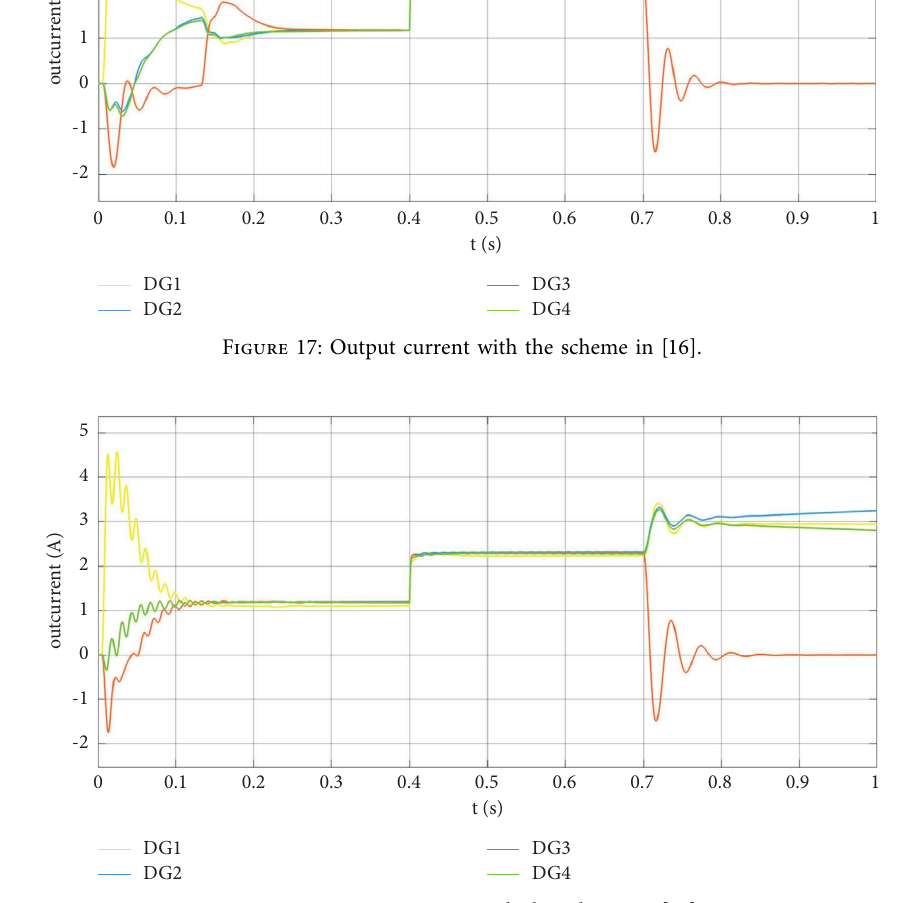
Figure 18: Output current with the scheme in